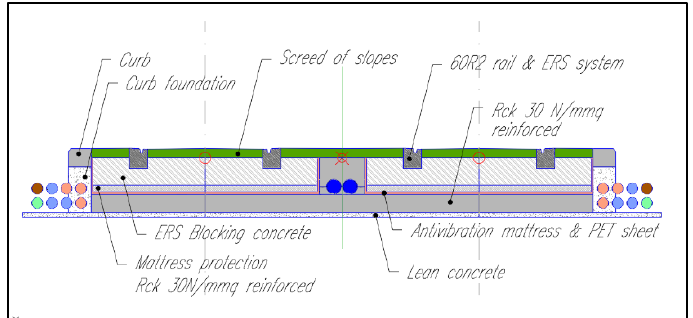
Figure 6. Typological Tram system BD_L2 section by Subassembly Composer.